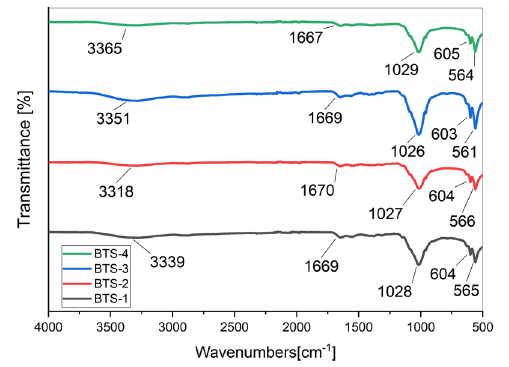
Figure 4. FT-IR graph of biocomposite scaffolds: (a) BTS-1, (b) BTS-2, (c) BTS-3 and (d)